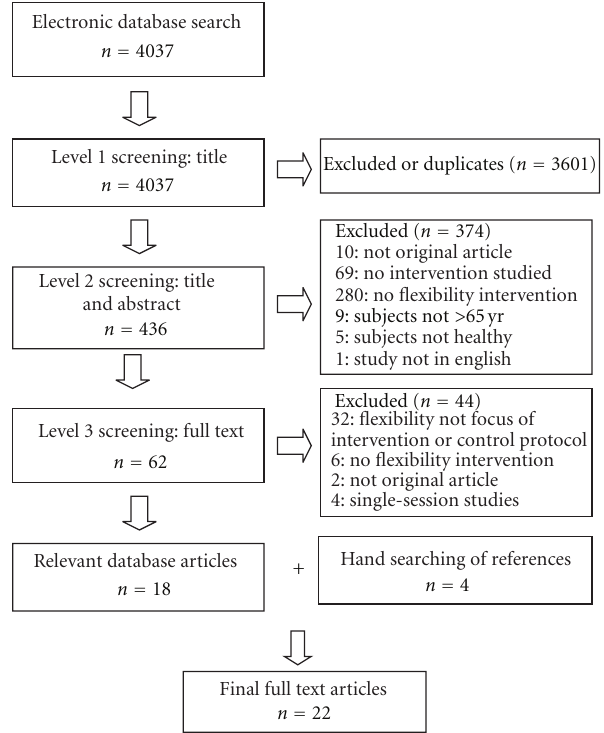
Figure 1: Article Screening Flow